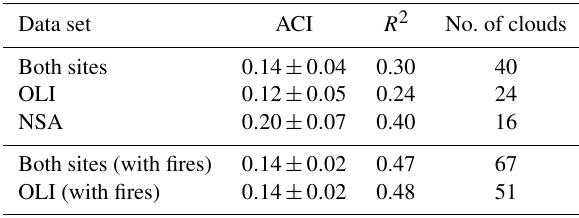
Table 1. ACI values for the subsets presented in Fig. 14. Data